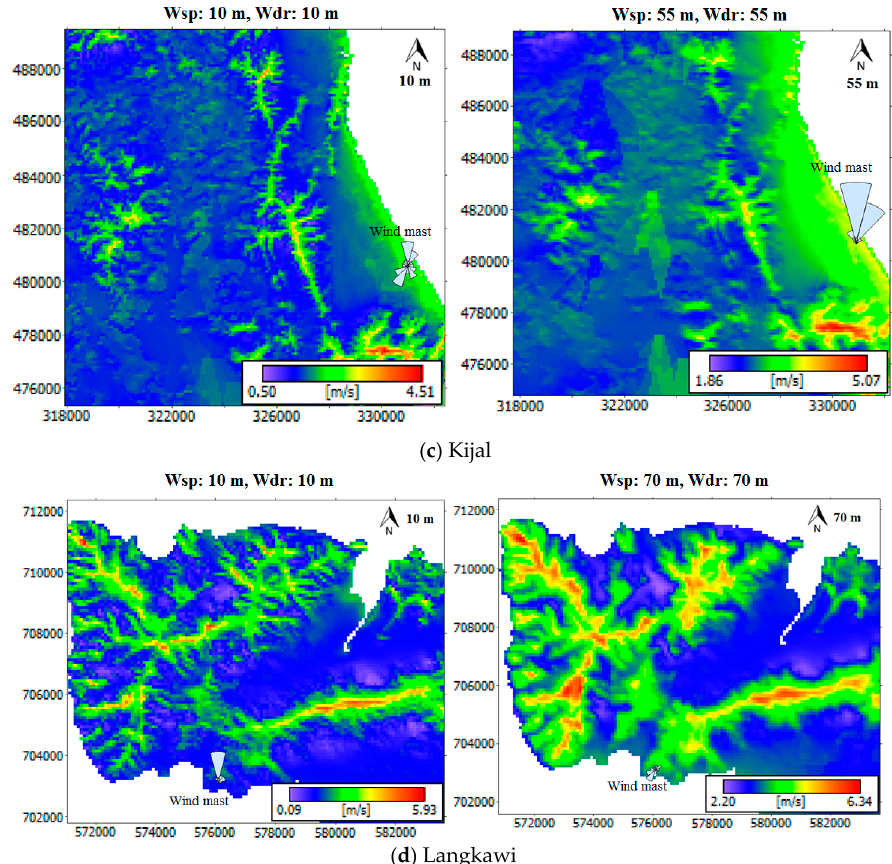
Figure 4. The 100 km 2 wind resource maps ( a ) Kudat; ( b ) Mersing; ( c ) Kijal; ( d ) Langkawi.